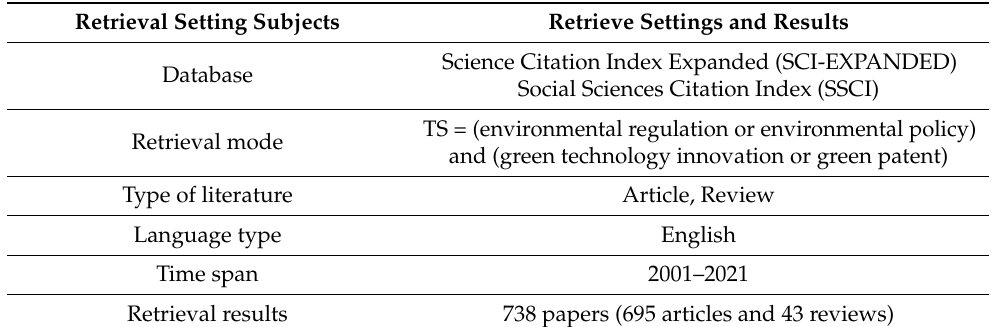
Table 1. Research data retrieval process in Web of